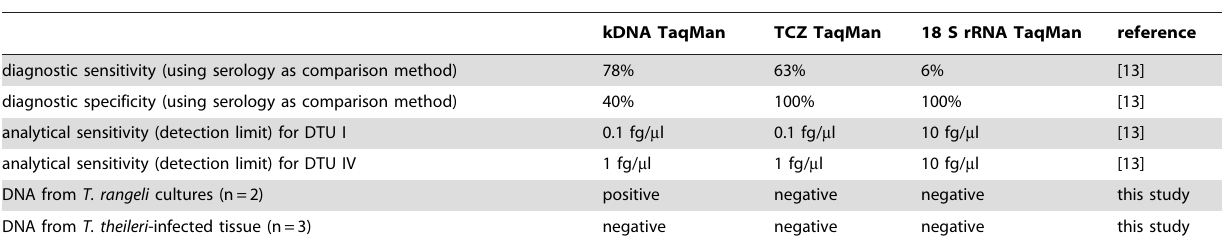
Table 2. Validation data for the real-time PCR